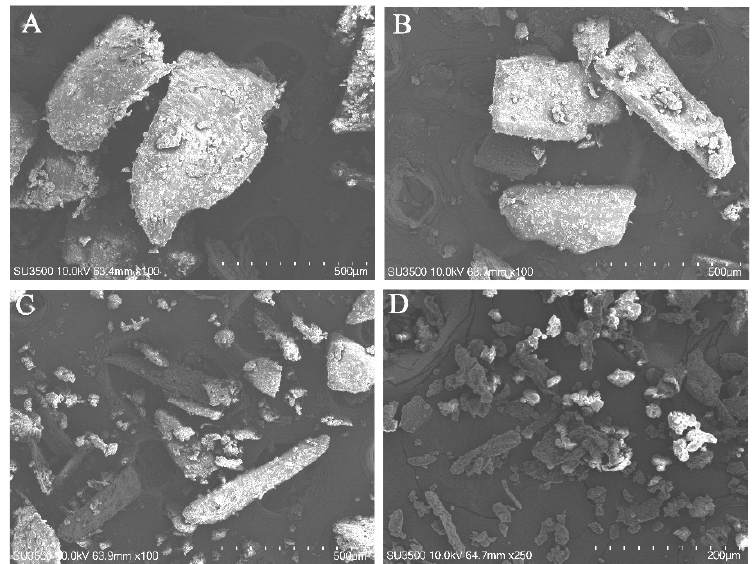
Figure 1. The Scanning electron microscopy (SEM) micrographs of the foxtail millet bran powder, with different particle sizes. ( A ) M60 100 × ; ( B ) M60–80 100 × ; ( C ) M80–120 100 × ; ( D ): M120 250 × .